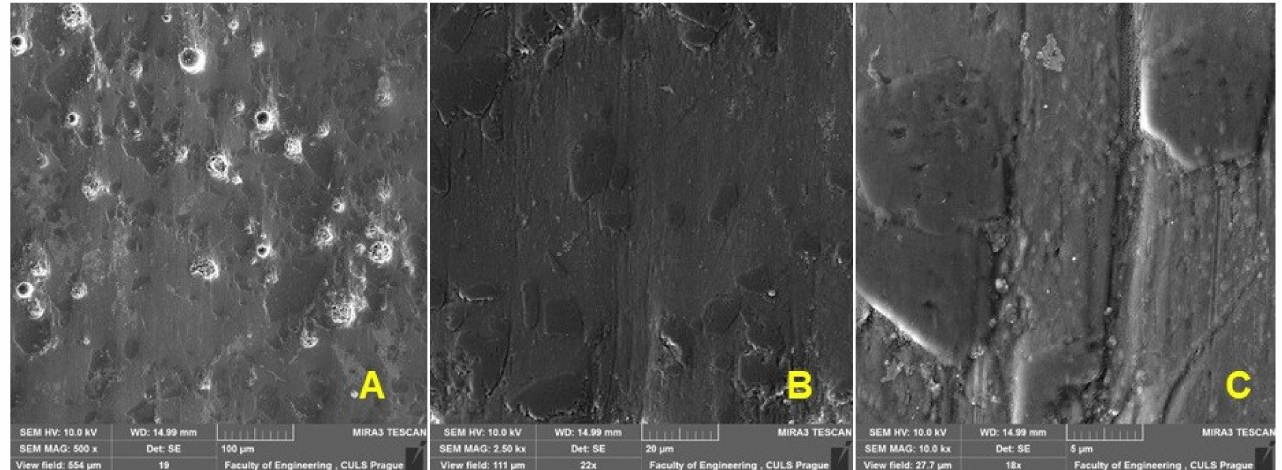
Figure 13. SEM analysis of the surface—the central part of the wear mark, in which intense wear acted on the enamel surface: ( A ): a macroscopic image of the surface (MAG 500 × ), ( B ): a detailed image of the surface (MAG 2.5k × ), ( C ): a detailed image of the surface (MAG 10.0k × ).